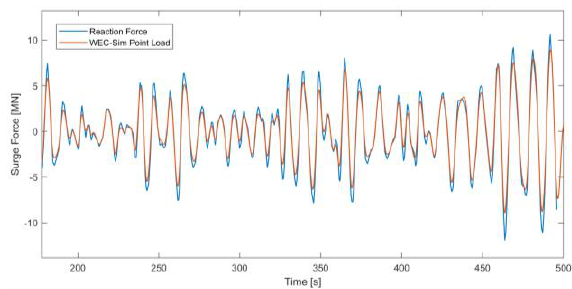
Fig. 8. Time series of total surge force – WEC-Sim rigid body solution (red) and static analysis (blue); the ramp-up time (0- 200s) is